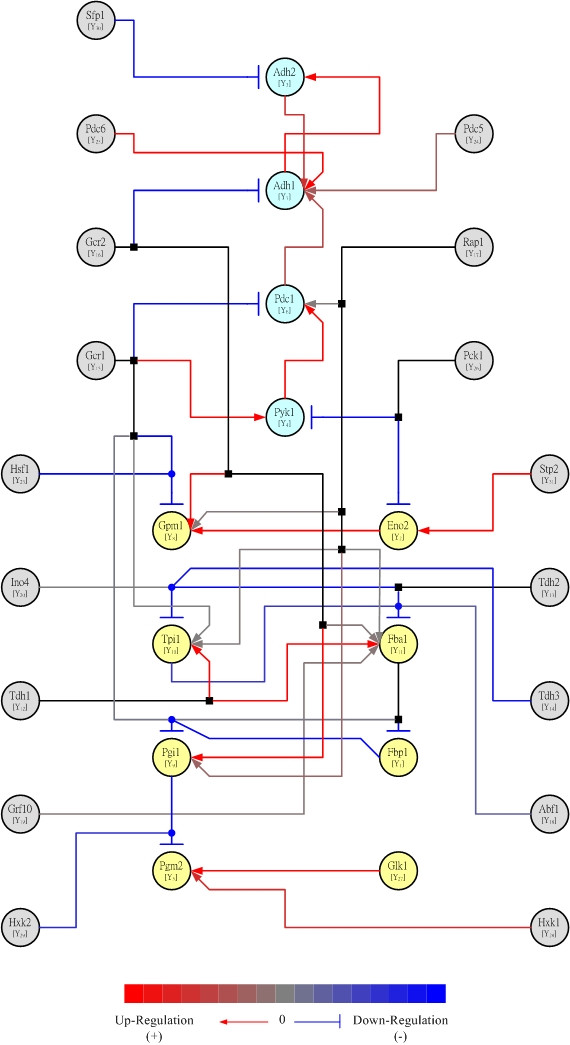
The metabolic shift pathway of yeast Saccharomyces cerevisiae according to the dynamic regulatory modeling in Table 2. The related genes are represented as ovals with different colors of light blue (fermentation), light yellow (gluconeogenesis), and gray (other relevant genes not as target genes). There are three types of lines with colors of red (activation), blue (repression), and black. In addition to the black line representing the signal pipes from genes, the red lines are shown depending on the degree of activation whilst the blue lines are shown depending on the degree of repression. The black square symbol attached on the lines is the bifurcate node from the same signal source. And the circle symbol attached on the lines is the collecting nodes from different signal sources. The colored degree bar between activation and repression is also shown in the bottom of the figure.